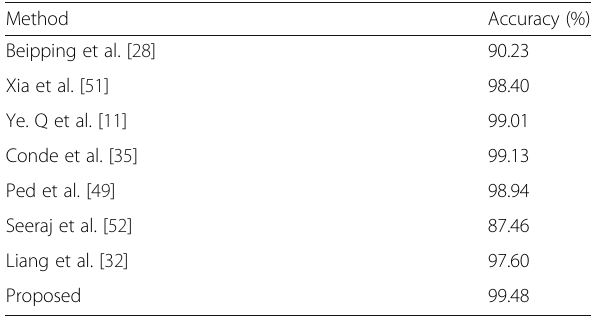
Table 6 Results of the proposed algorithm compared using four classifiers on our recorded videos Method